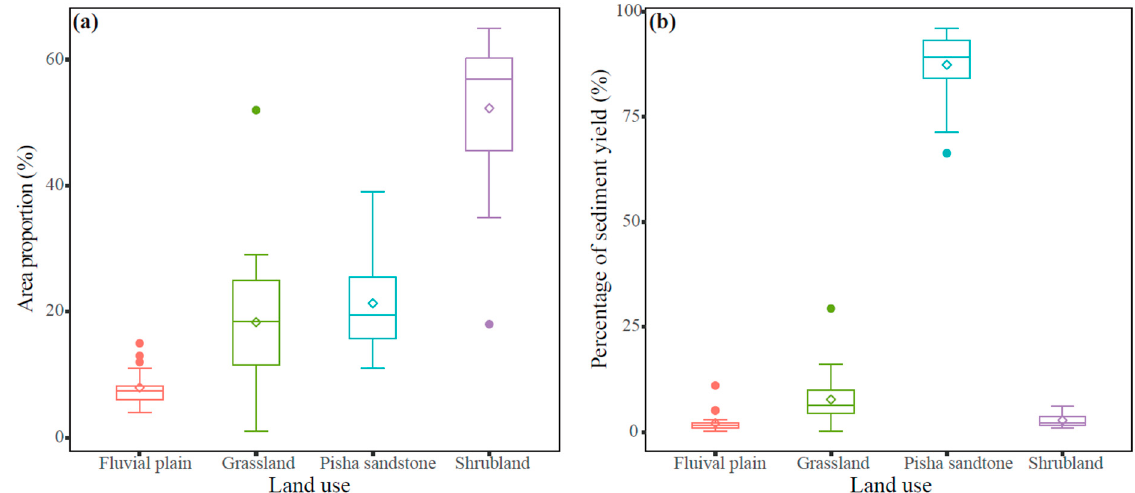
Figure 6. Sediment yield from different land use/cover types. ( a ) Area proportion and ( b ) the percentage of sediment yield for different land use/cover types.